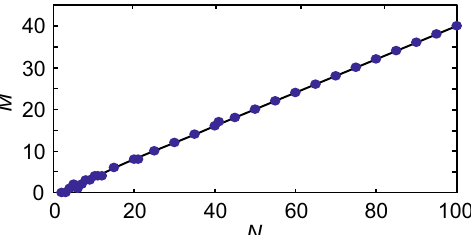
Fig. 4 Number of positive Lyapunov exponents M vs. number of qubits N in the ring chain. Δ = 5, Ω = 2.5, c =